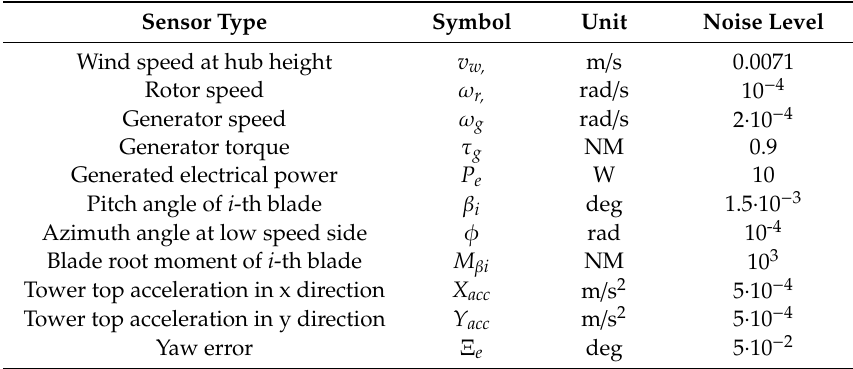
Table 2. Available sensors and added noise